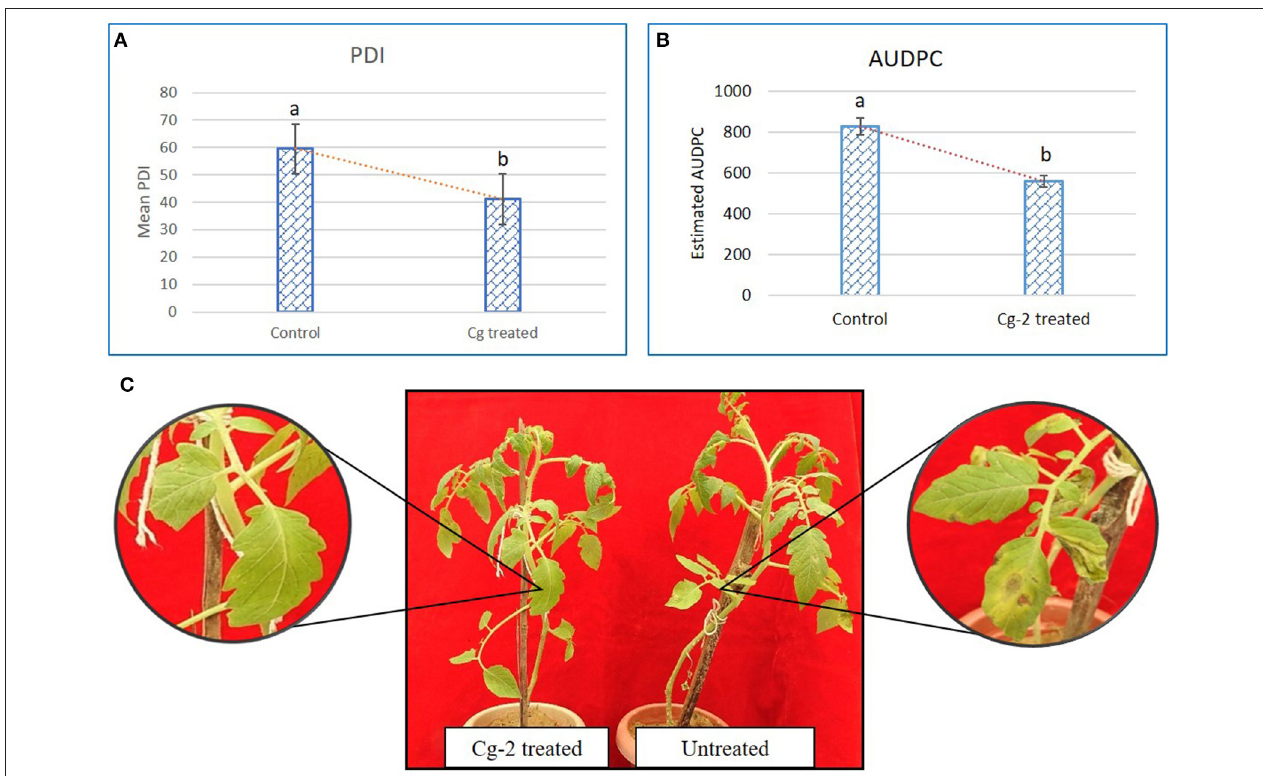
FIGURE 2 | Chaetomium globosum induced systemic resistance against early blight in tomato plants. (A) Mean PDI of control plant and Cg-2 treated plants. (B) Area under disease progress curve by plotting disease progress curve with PDI at Y -axis and time points 0, 7, 14, and 21 dpAi at X -axis. (C) A. solani symptom development in C. globosum treated and untreated control